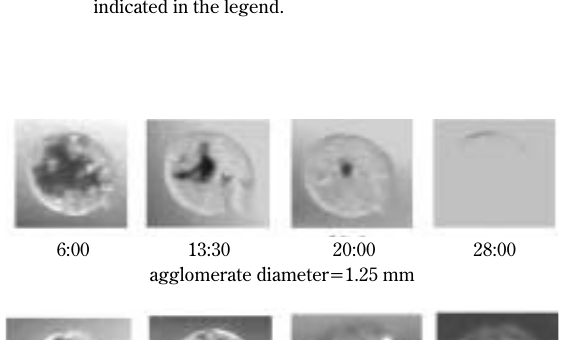
Extent of infiltration as a function of time for the hydropho- bic agglomerates. The diameter of each agglomerate is indicated in the